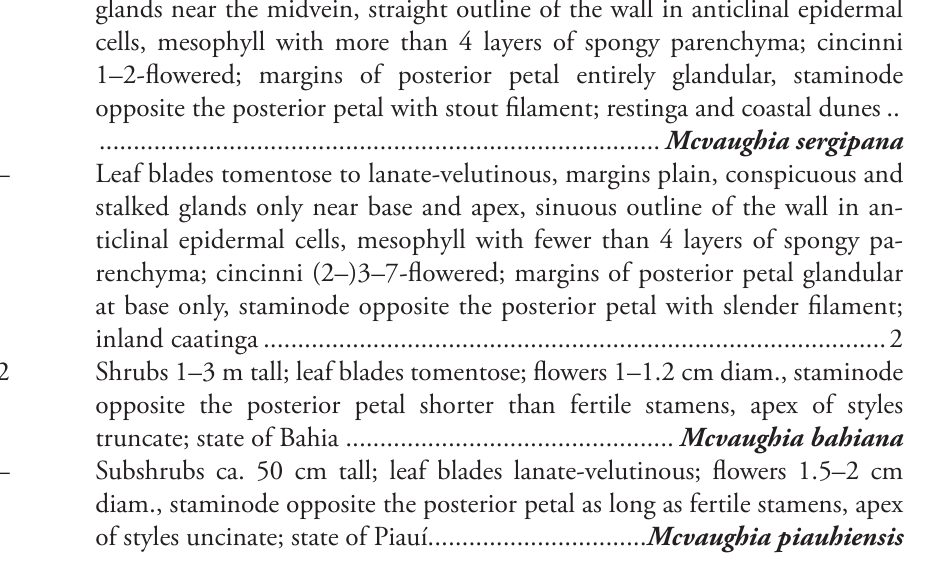
Type. BRAZIL. Bahia: Conceição do Coité, road from Coité, 12 km to Santaluz, fl. Fr., 6 Mar 1976, W.R. Anderson 11740 (holotype: MBM barcode MBM59835!; isotypes: F barcode F0062743F!, G barcode G00352842!, K barcode